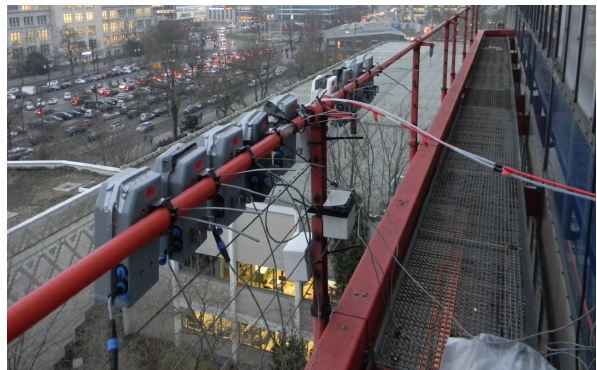
Figure 3. Set-up of the co-location of the prototype Zephyrs with reference instruments on the sixth floor of the mathematics building. The grey units are the Zephyrs, and the two inlet tubes connect to the reference devices located inside the